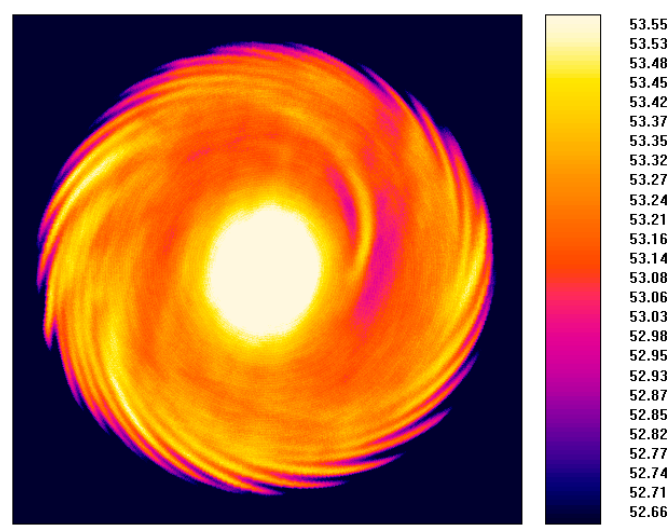
Figure 6. Reconstructed thermogram of spiral vortices on a rotating disk for Re = 300,000.